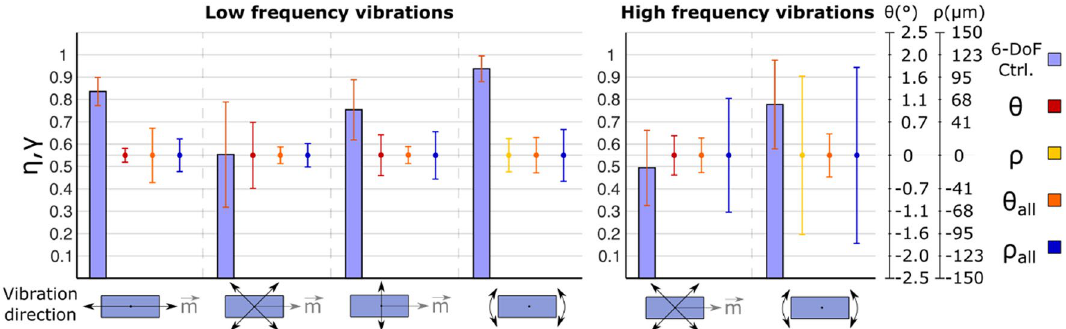
Figure 7. Efficiency and deviation for the two magnets 12-DoF control test (Group III). In all cases, one magnet was kept still and a second one was moved along directions indicated with black arrows. Bar plots (mean ± standard deviation) indicate the efficiency ( η , γ ) of the vibrations generated on the moved magnet (6-DoF control). The dots (mean ± standard deviation) indicate the displacement signal for the moved ( θ or ρ , depending on the test condition) and still ( θ all , ρ all )